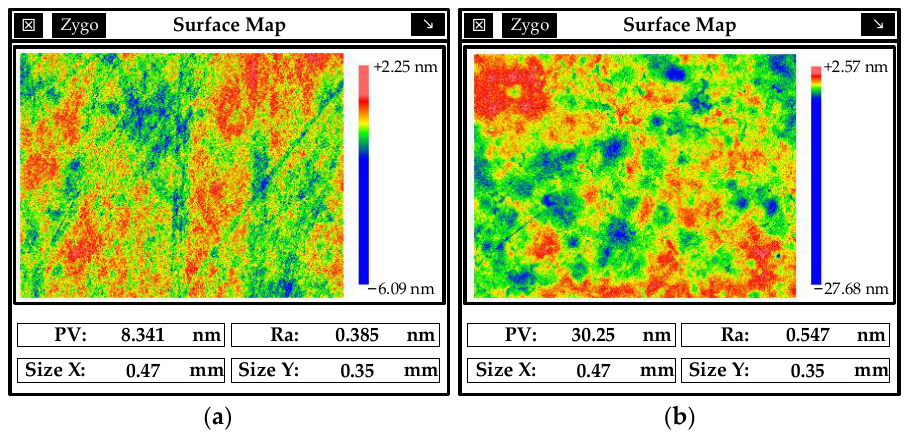
Figure 12. Influence of smoothing process optimization on surface roughness. ( a ) Surface roughness optimized by smoothing process; ( b ) surface roughness with too strong chemical action of smoothing fluid.